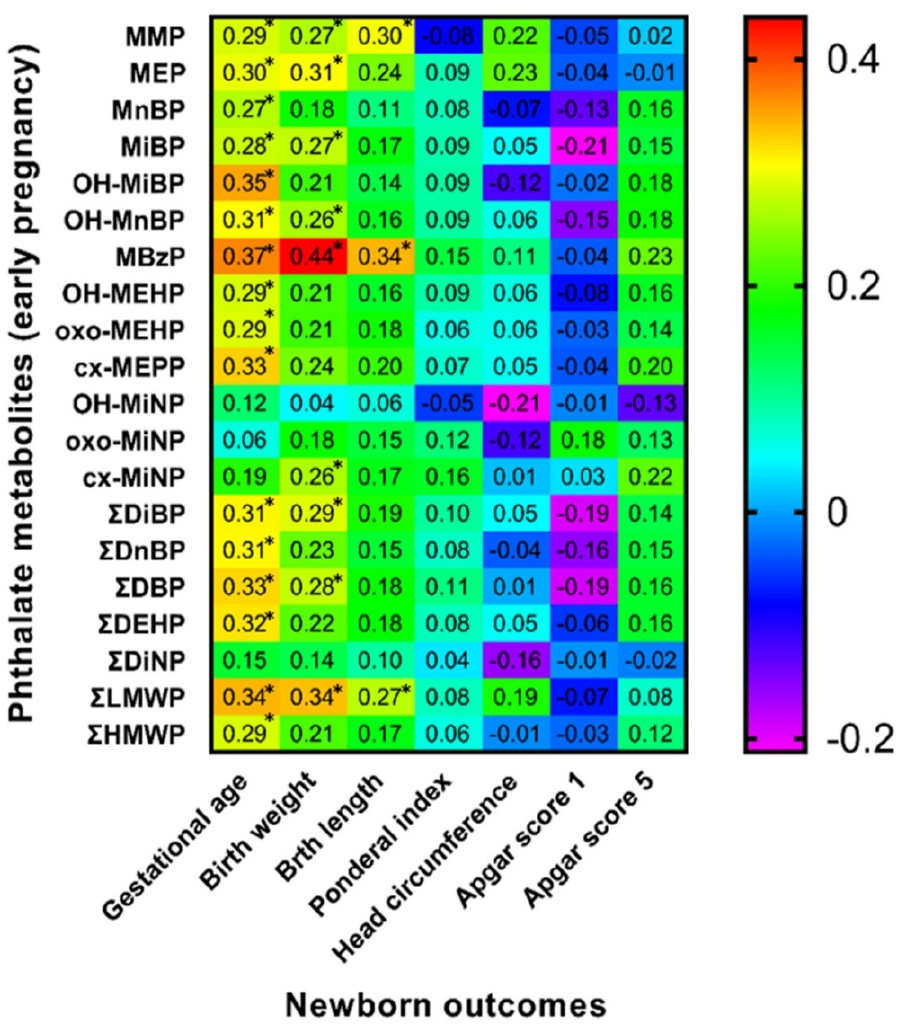
Figure 1. Correlation matrix of newborn outcomes and maternal phthalate metabolites during early pregnancy ( ≤ 15. w.g.). Legend is shown in the footnote of Table 4. * The correlation is significant at the level p ≤ 0.05.